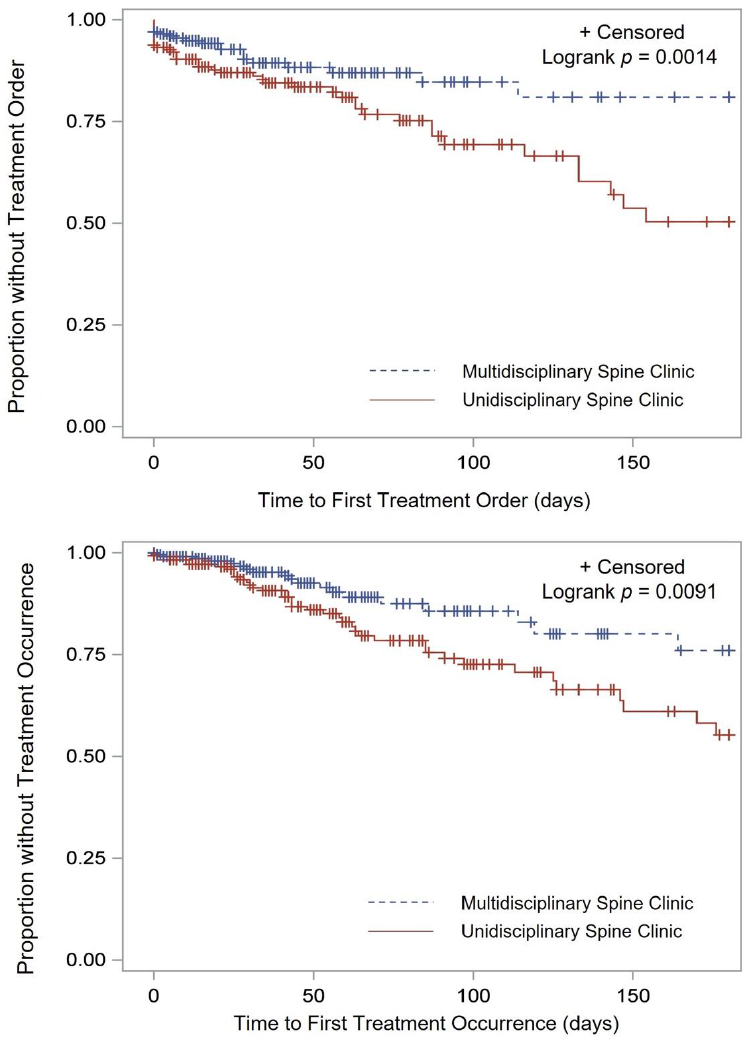
Figure 2. Time to surgery order ( top ) and occurrence ( bottom ).